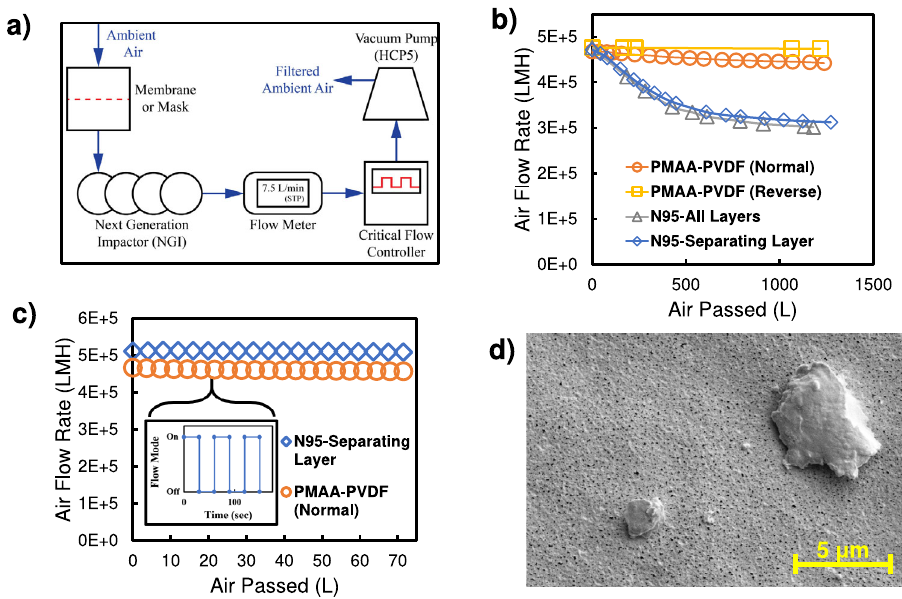
Fig. 5 Ambient air fi ltration through membrane and fi lter material. a Schematic of ambient air- fi ltration testing of membrane and mask material. Ambient air fl ux through PMAA-PVDF membrane (normal and reverse orientation), N95 commercial mask (forward orientation), and N95 separating layer (layer 3) under a consistent pressure with b continuous fl ow mode and c sinusoidal fl ow mode of 30 s with fl ow on and 30 s with fl ow off (blue diamond and line for N95-separating layer, gray triangle and line for N95-all layers, orange circle and line for PMAA-PVDF-Normal, and yellow square and line for PMAA-PVDF- Reverse). d SEM of membrane fouling of PMAA-PVDF membrane after ~500 L of ambient air- fi ltration. Beginning air fl ux was set at 7.50 ± 0.50 L/min (average breathing rate). Flow rate measurements normalized at STP. 3 different measurements were taken on the samples (standard deviation resulted in less than